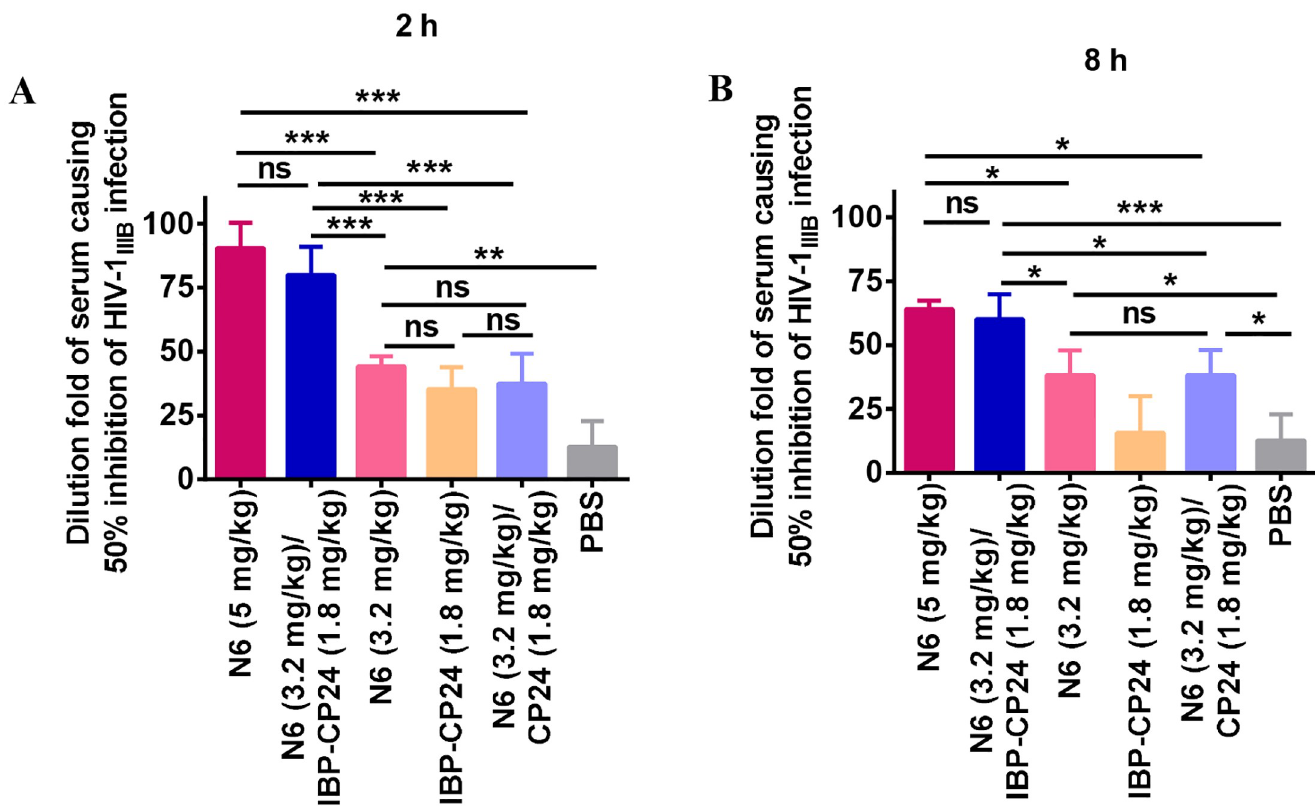
Fig 9. The ex vivo anti-HIV-1 activity of IBP-CP24 in combination with N6 at different concentration. The anti-HIV-1 IIIB activity of the sera collected from the mice 2 h (A) and 8 h (B) post-injection via i . p . with the N6 (5 mg/kg), N6 (3.2 mg/kg)/IBP-CP24 (1.8 mg/kg) combination, N6 (3.2 mg/kg), IBP-CP24 (1.8 mg/kg), and N6 (3.2 mg/kg)/CP24 (1.8 mg/kg) combination, respectively. The dilution fold of the serum causing 50% inhibition of HIV-1 IIIB infection (DF-IC50) was calculated. Each sample was tested in triplicate and data were presented as mean ± SD. Unpaired, 2-tailed t test was performed. "ns" means no significance; � P < 0.05, �� P < 0.01, and ��� P <